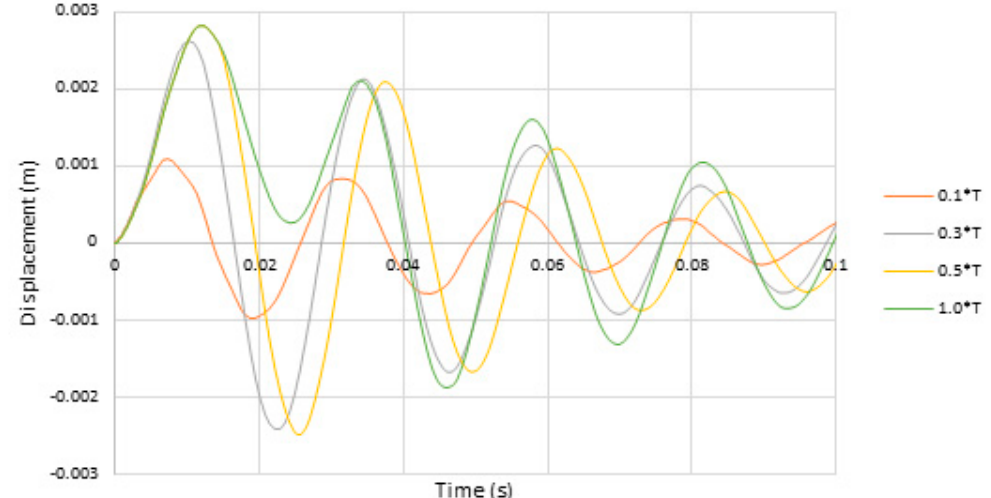
Figure 14. Vibration of loaded section under side force. Simulation results.